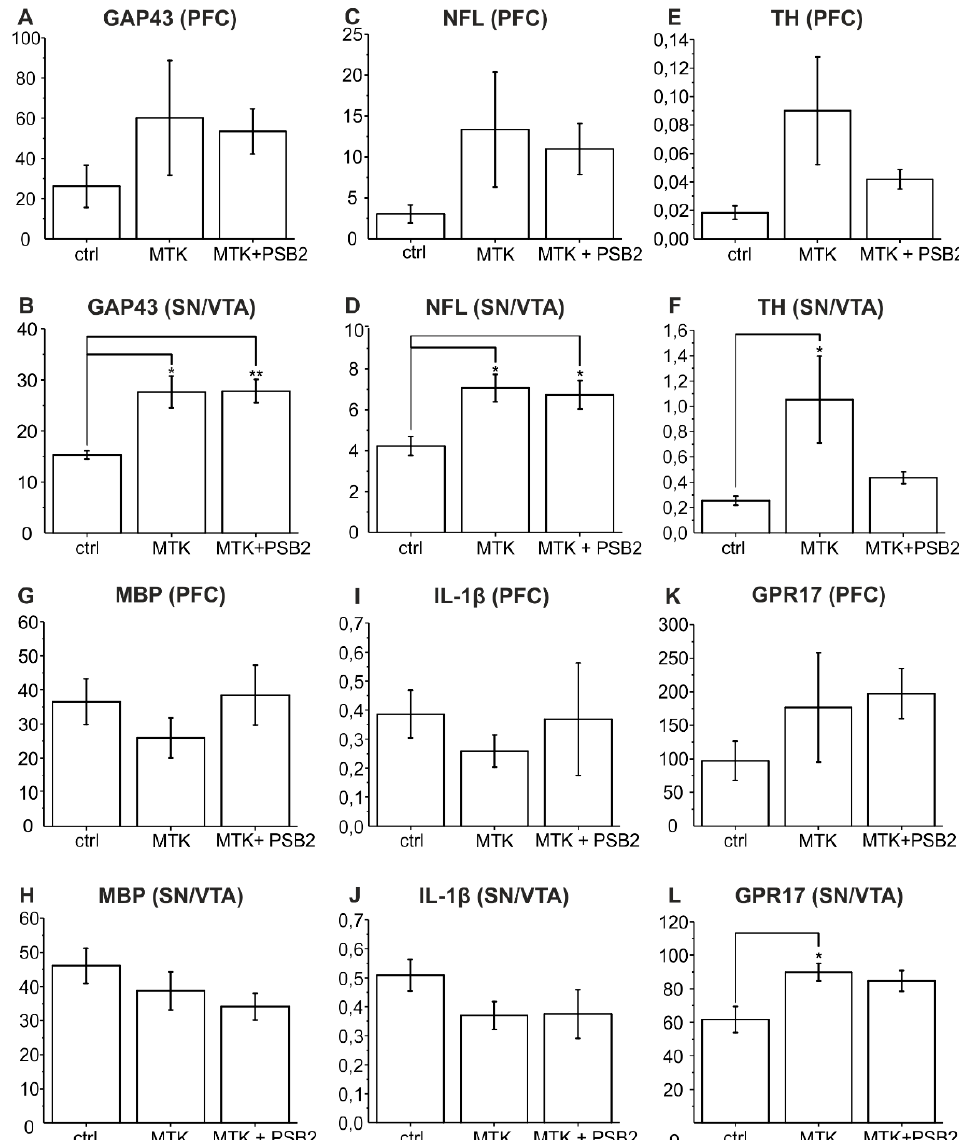
Figure 3. Results of RT-qPCR experiments in the PFC and SN/VTA. Expression of mRNA of GAP43 ( A , B ), NFL ( C , D ), TH ( E , F ), MBP ( G , H ), IL-1 β ( I , J ), GPR17 ( K , L ) is shown on y -axis as ∆ CP. X-Axis represents the different treatments (1% ethanol and 0.01% DMSO as controls (ctrl); 10 µM MTK and 0.01% DMSO; 10 µM MTK and 3 µM PSB-16484 (PSB2)). Statistical analysis was performed in com-